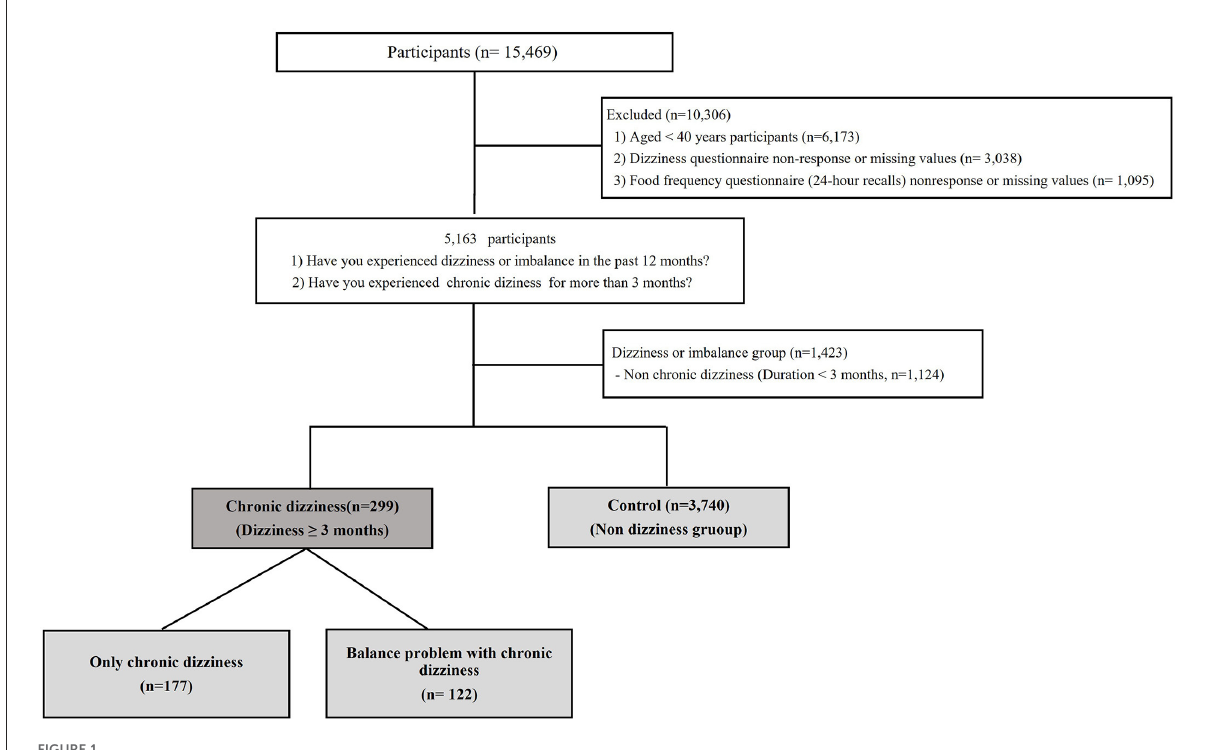
FIGURE1 Flow chart in this study.